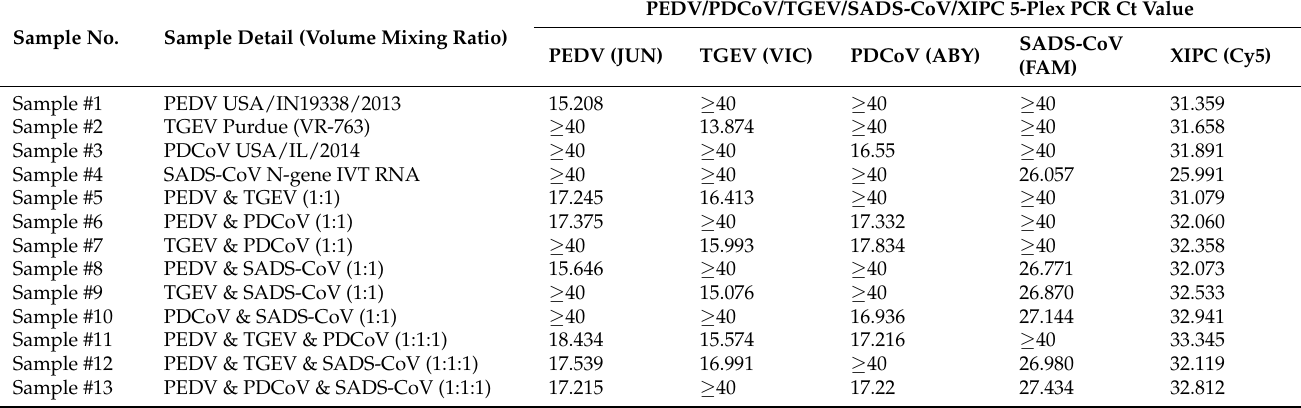
Table 4. Analytical specificity of the 5-plex PCR examined by mixtures of different